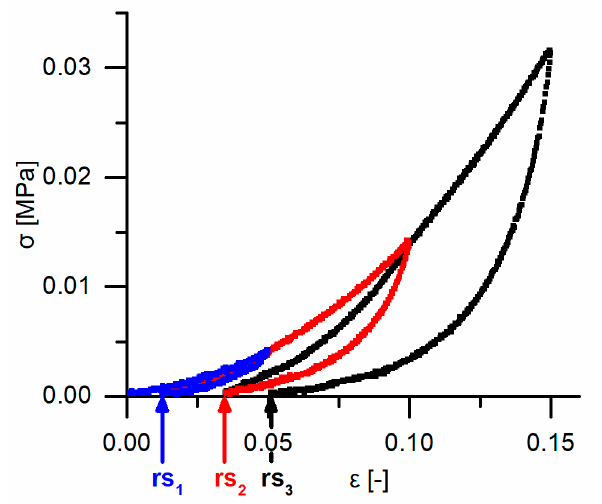
Figure 9. Exemplary stress–strain curve of a quasistatic stepwise cyclic compression test (strain rate 1 min − 1 ) consisting of three cycles, as sketched in Figure 16. The stress–strain curve of the first cycle is colored in blue, that of the second cycle is in red and that of the third cycle is in black. The residual strains of the first, second and third cycles are marked with rs 1 , rs 2 and rs 3 , respectively.